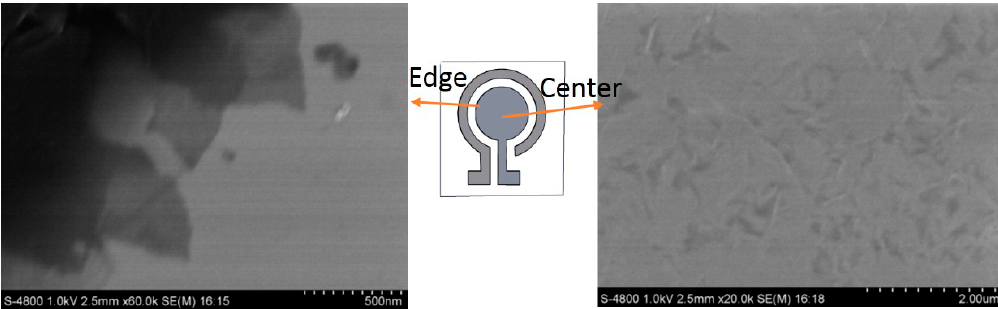
Figure 2. SEM of the center and edge of Gr/ L -cysteine/Au electrode.